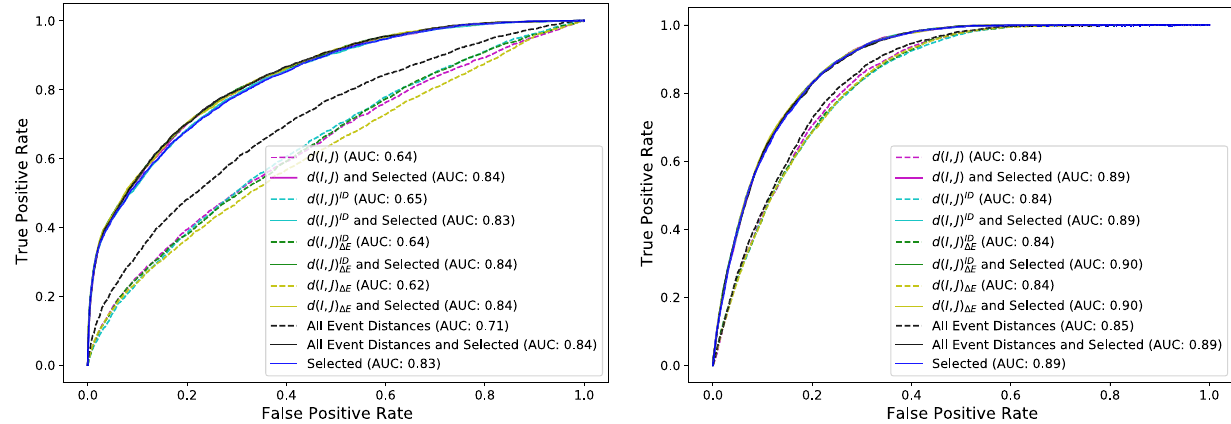
Fig. 8 ROC curves for the (left) Fake and (right) t ¯ tZ identification under different combination of features